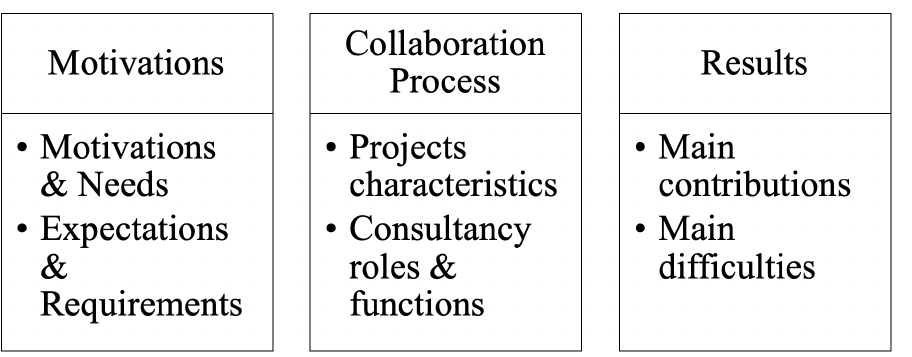
Fig. 1. Components analyzed in the